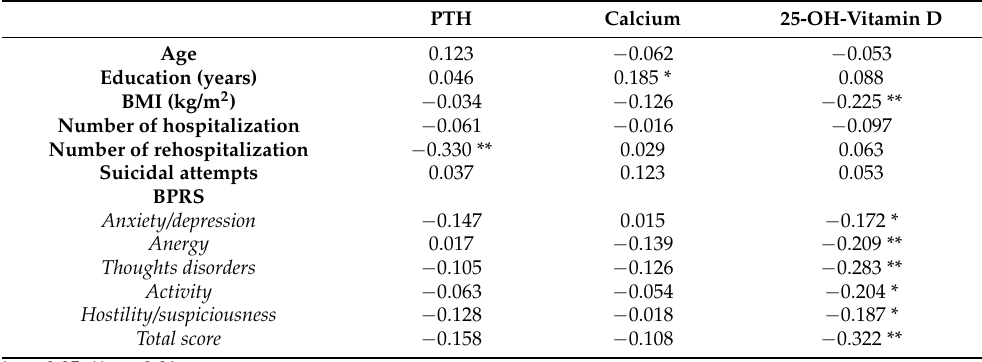
Table 2. Pearson rho correlation coefficients of serum levels of PTH and calcium and 25-OH-vitamin D, clinical variables, and psychopathological scores.